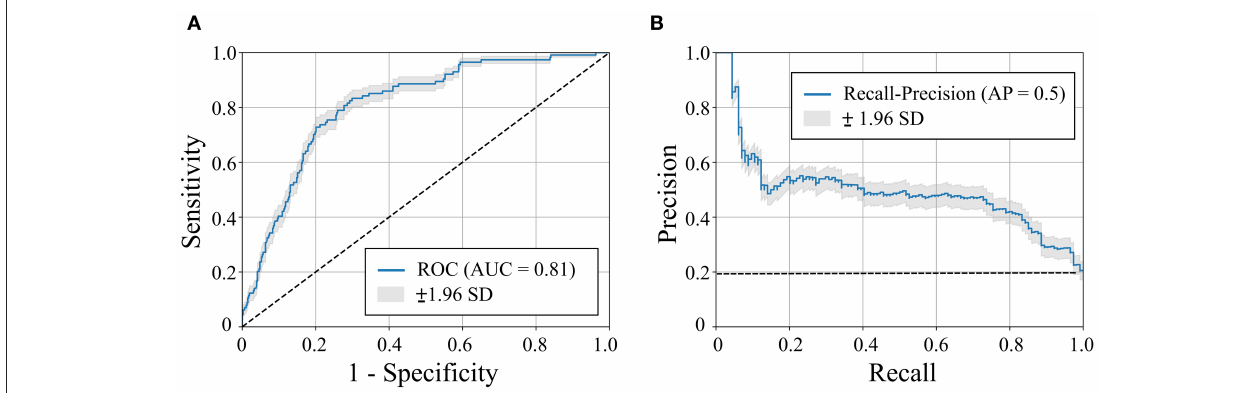
FIGURE 3 | Receiver operating characteristic (ROC) curve (A) and recall-precision curve (B) for the machine learning-based heart failure (HF) risk stratification in hypertrophic cardiomyopathy patients ( n = 572). Dashed line represents pure-chance stratification AUC = 0.5 in (A) or precision = ratio of HF outcomes in the dataset ( = 20%) (B) . AUC = area under the curve. AP, average precision; SD, standard deviation.